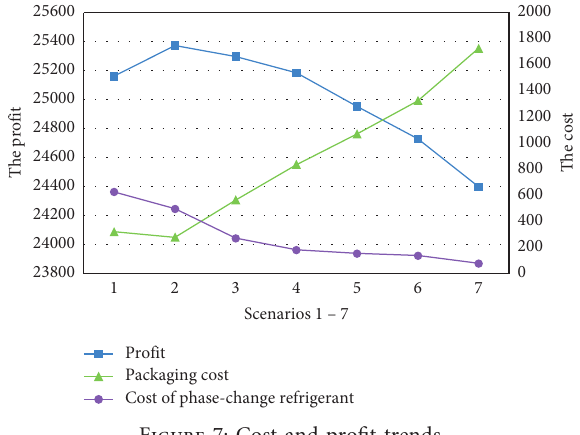
Figure 7: Cost and profit